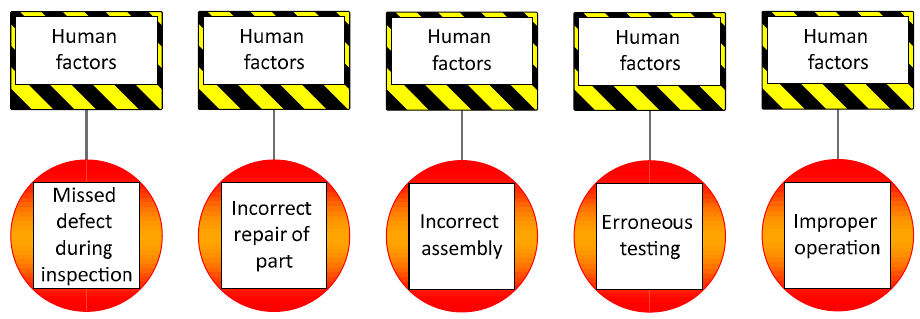
Figure 4. Hazard investigation with different top events.